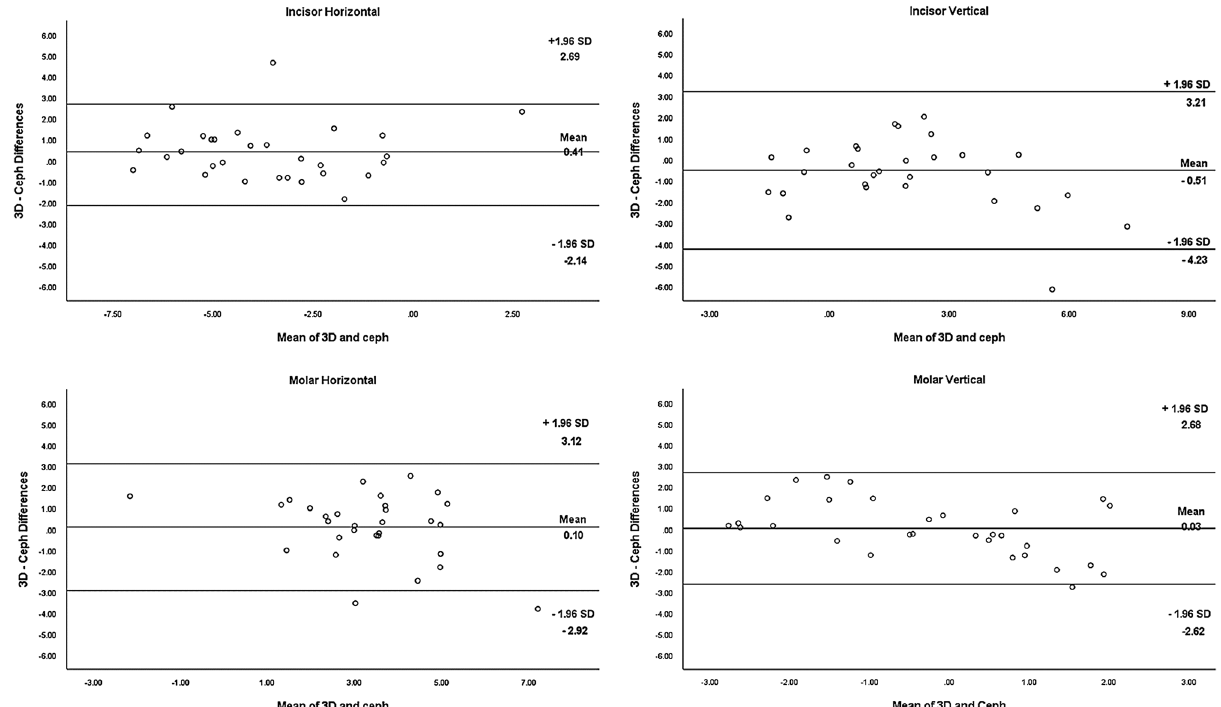
Figure 5. Bland-Altman plots for horizontal and vertical distance of the central incisor and first molar using two methods.